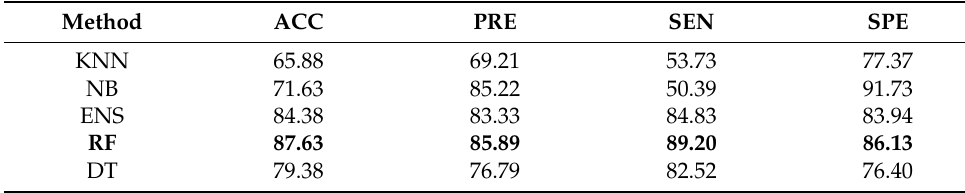
Table A5. AF detection performance based on time and time-frequency